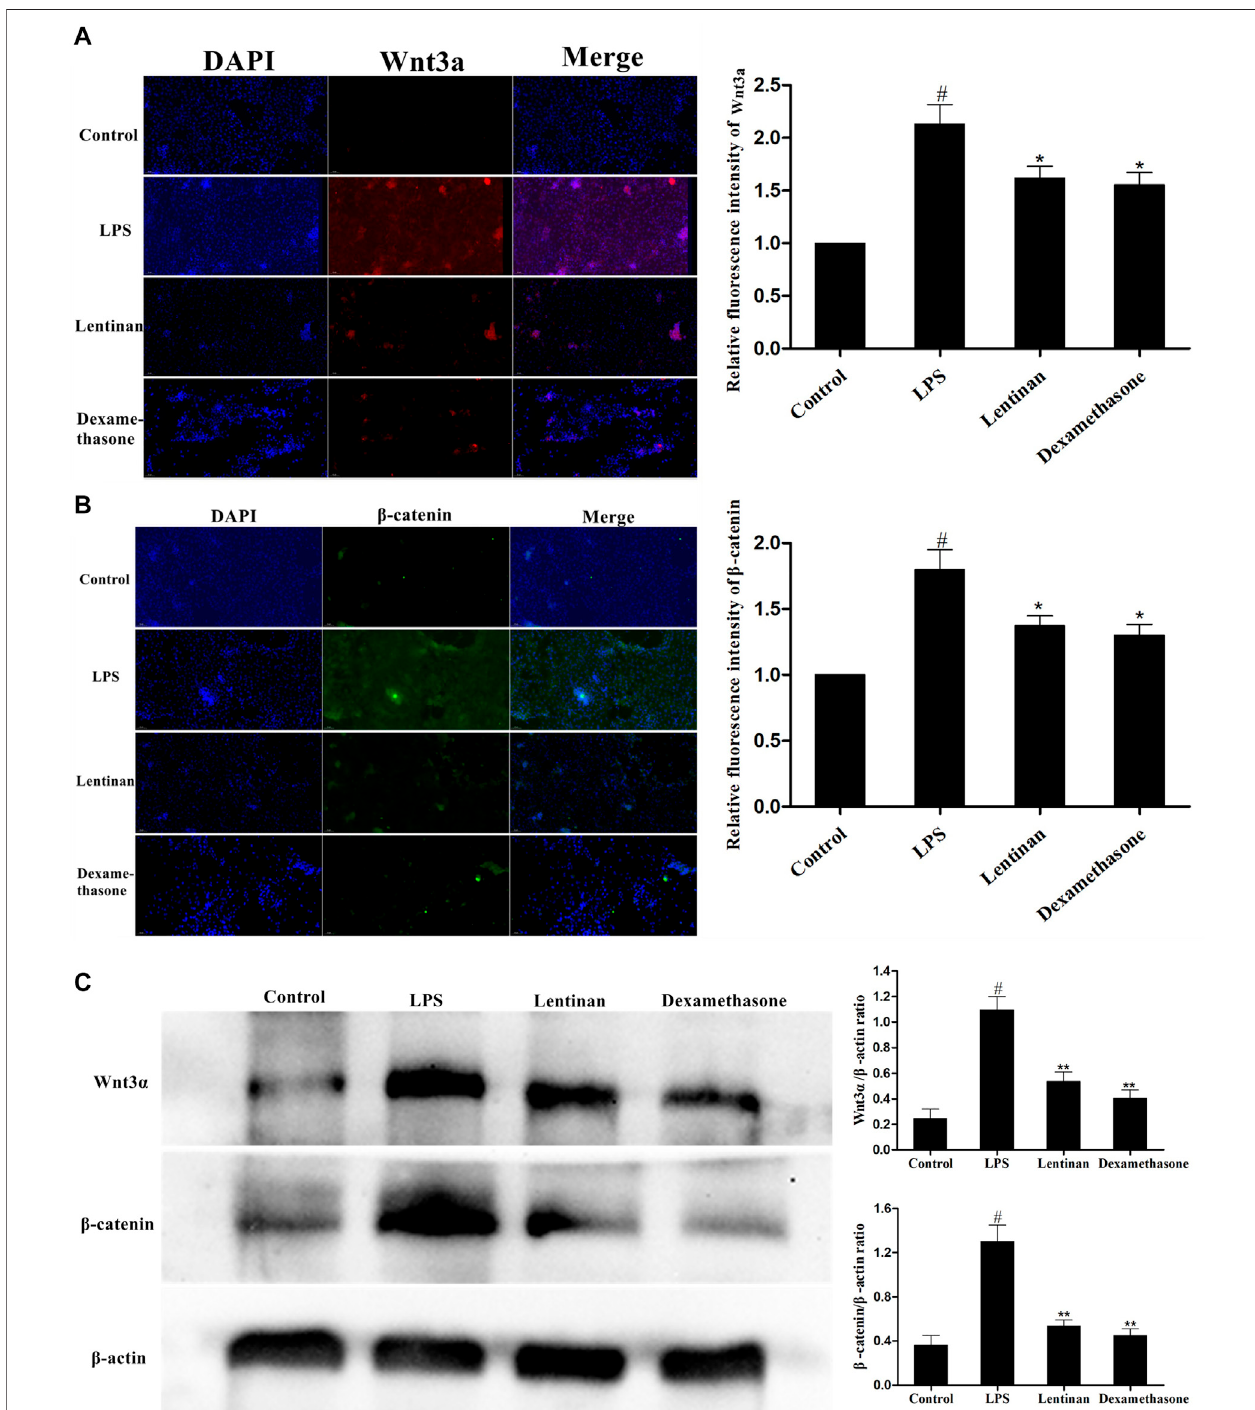
FIGURE 7 | Effects of lentinan on the activation of the Wnt/ β -catenin pathway in mMECs. (A,B) The activation of the Wnt/ β -catenin signaling pathway in LPS- stimulated mMECs was also determined by the immuno fl uorescence technique. (C) The expression of Wnt/ β -catenin proteins was detected by western blot. β -actin served as an internal control. All data are represented as the mean ± S.E.M. of three replicates.